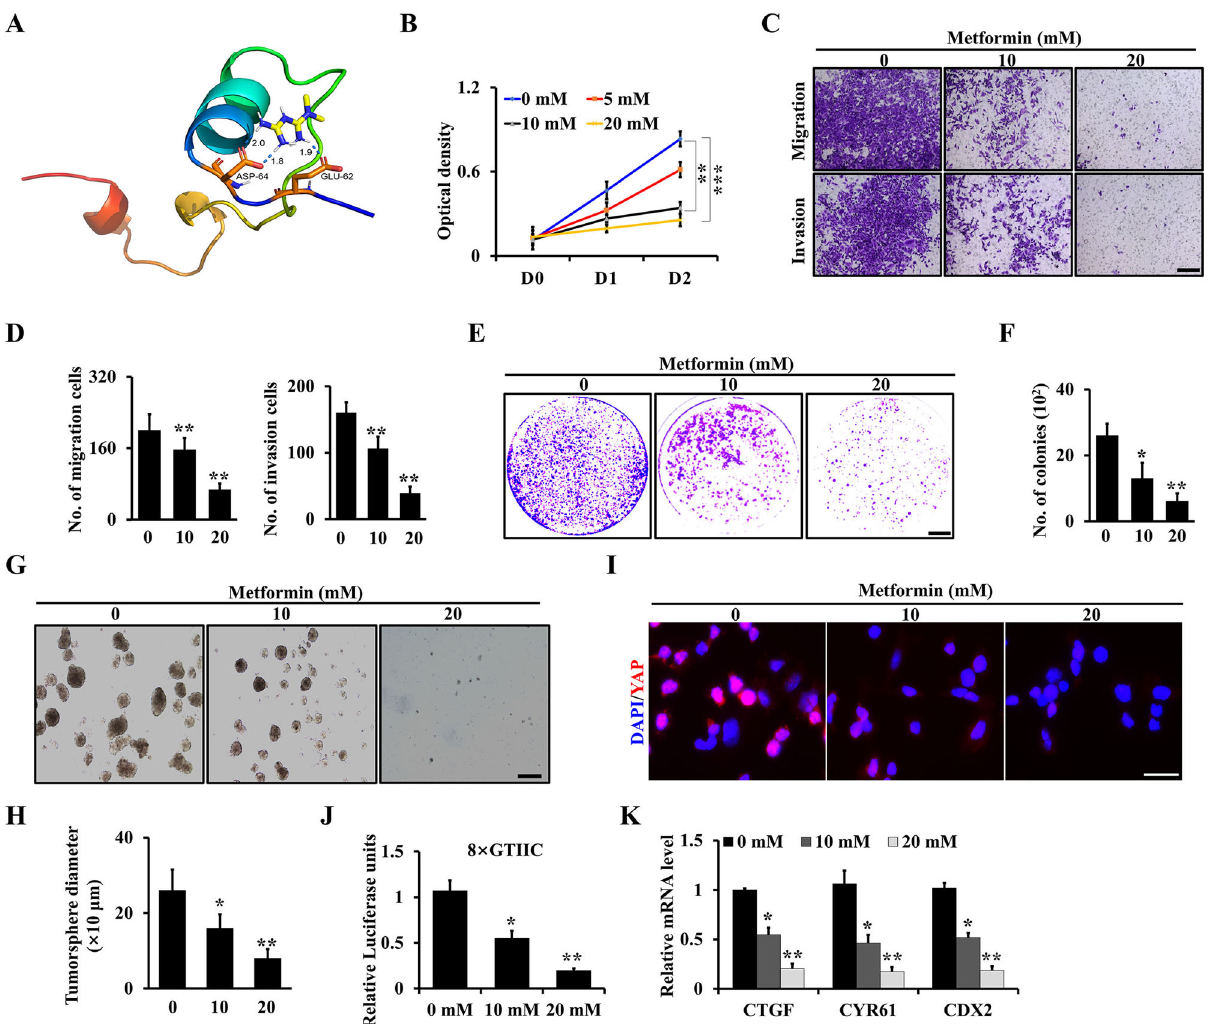
Fig. 5 Metformin inhibits chondrosarcoma progression through YAP signaling. A Docking between YAP (6GE3 from PDB) and metformin. B After treatment of different doses of metformin as shown, the cell proliferation was determined at D0, D1, and D2 using primary chondrosarcoma cells from Col2-Cre;Trp53 f/f /Rb1 f/f mice. C Representative images of migration and invasion after treatment of different doses of metformin as indicated using primary chondrosarcoma cells. D The quantitative analysis of migration and invasion based on C . N = 3. E , F Representative images of soft agar ( E ) and quantitative analysis ( F ) after treatment of metformin as shown for 3 weeks. N = 3. G , H Representative images of tumorsphere ( G ) and quantitative analysis ( H ) after treatment of metformin for 3 days as indicated. N = 3. I Metformin inhibits YAP nuclear translocation. J After treatment with metformin of 48 h, luciferase activities were identi fi ed as indicated. K qRT-PCR analysis of YAP target genes ’ expression. Error bars were the means ± SEM from three independent experiments. * P < 0.05, ** P <